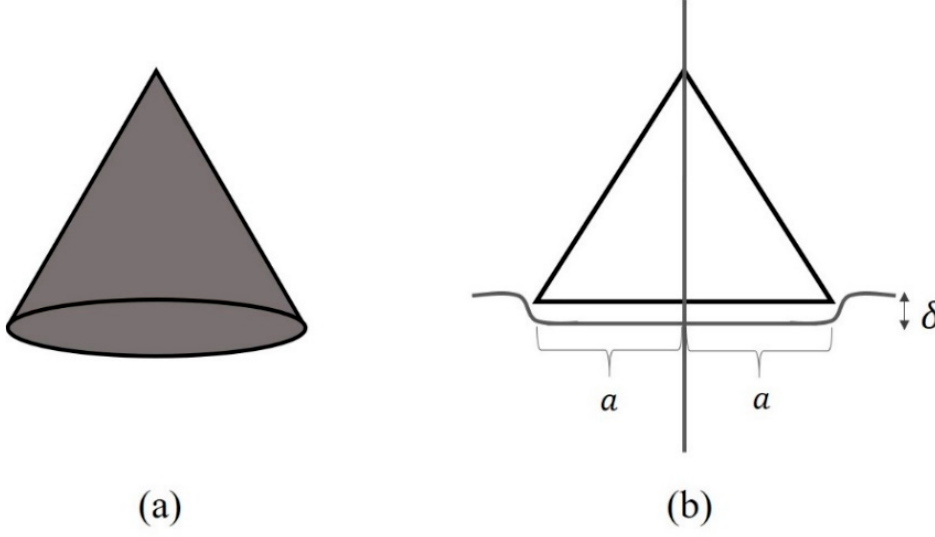
was in contact with the surface of the tissue. ( b ) Front view of the contact zone. Depth of the indentation is denoted by δ . Diameter of the base of the indenter is 2 a